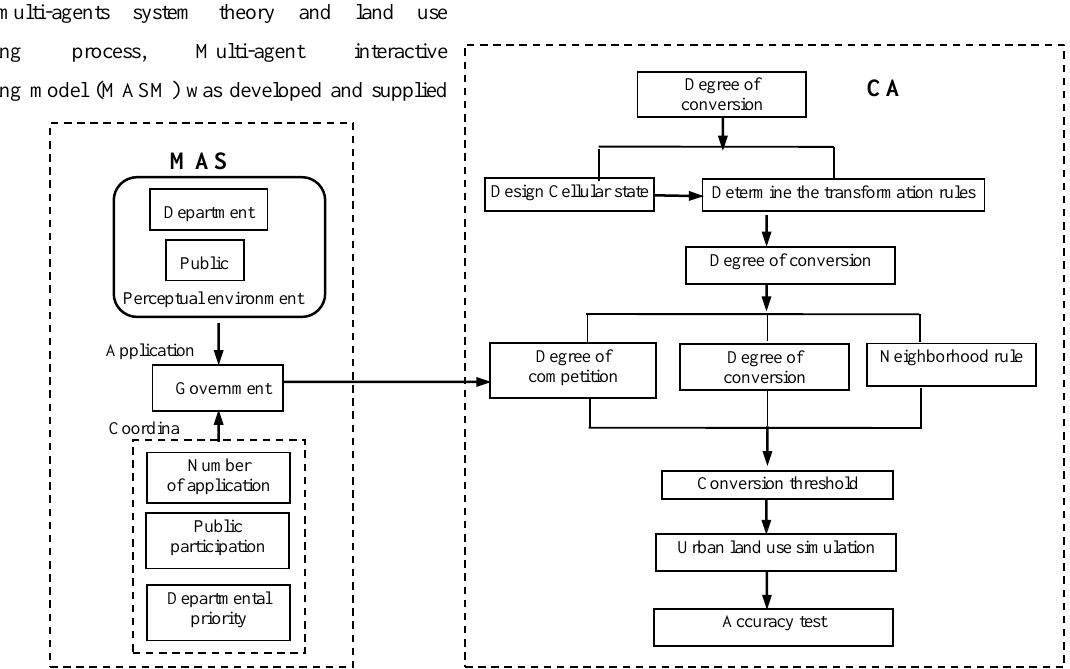
Figure 2. Model framework of MAS and